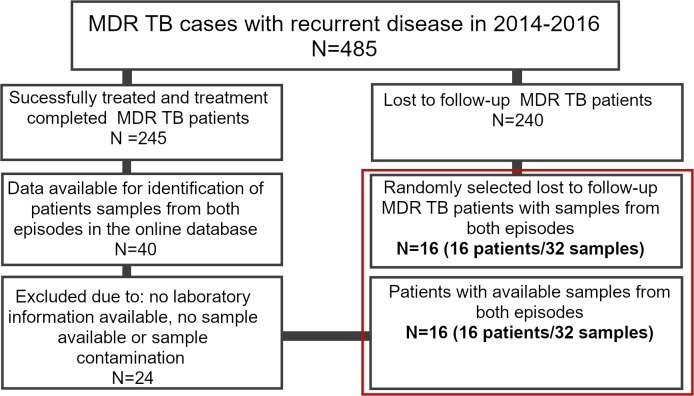
Flow diagram of selecting study participants.